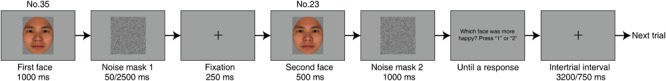
The trial procedure of Experiment 2. In each trial, the first facial expression was presented for 1000 ms, followed by a 50 ms or a 2500 ms noise mask 1. These two various durations were counterbalanced across sessions. After a 250 ms fixation cross, the second facial expression was presented for 500 ms, followed by a 1000 ms noise mask 2. Then the question “which facial expression was more happy” appeared until participants made a response by pressing “1” or “2.” The next trial started after a 3200 ms or a 750 ms intertrial interval, depending on the corresponding delay durations of noise mask 1.